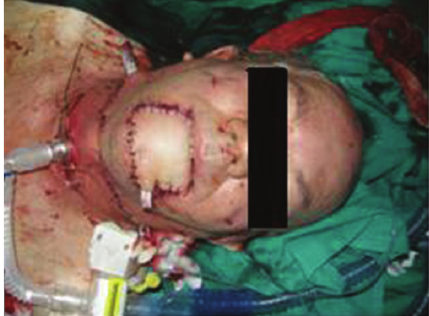
Figure 3: Reconstruction with the free composite radial forearm- palmaris longus flap.